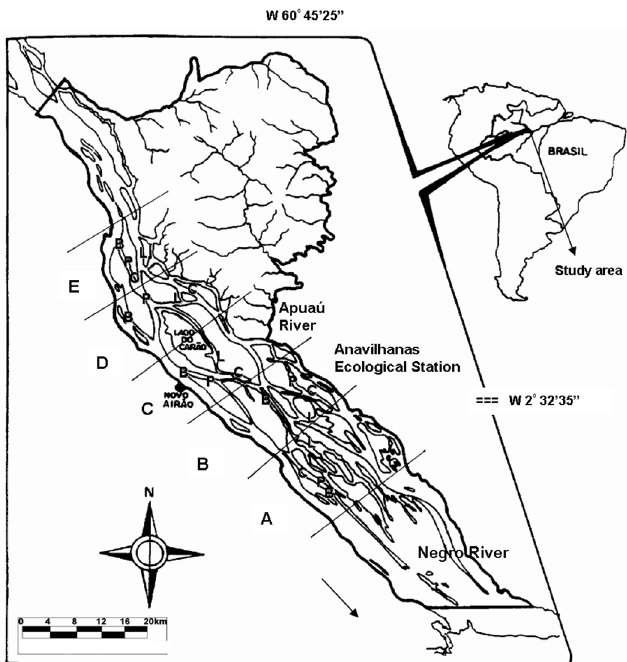
Fig. 1. Anavilhanas Ecological Station: A, B, C, D and E are the sub sections; beach (P). ravine (B) channel (C) and lake channel (L) are the microhabitats sampled; the arrow shows the direction of the